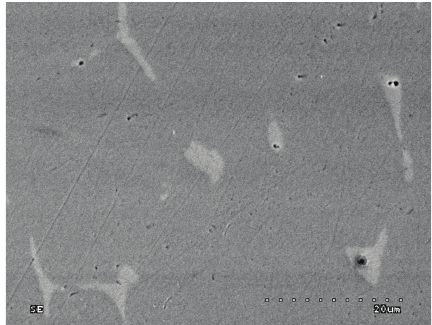
Figure 1: SEM image of TiO 2 coating on Magnum AN alloy.